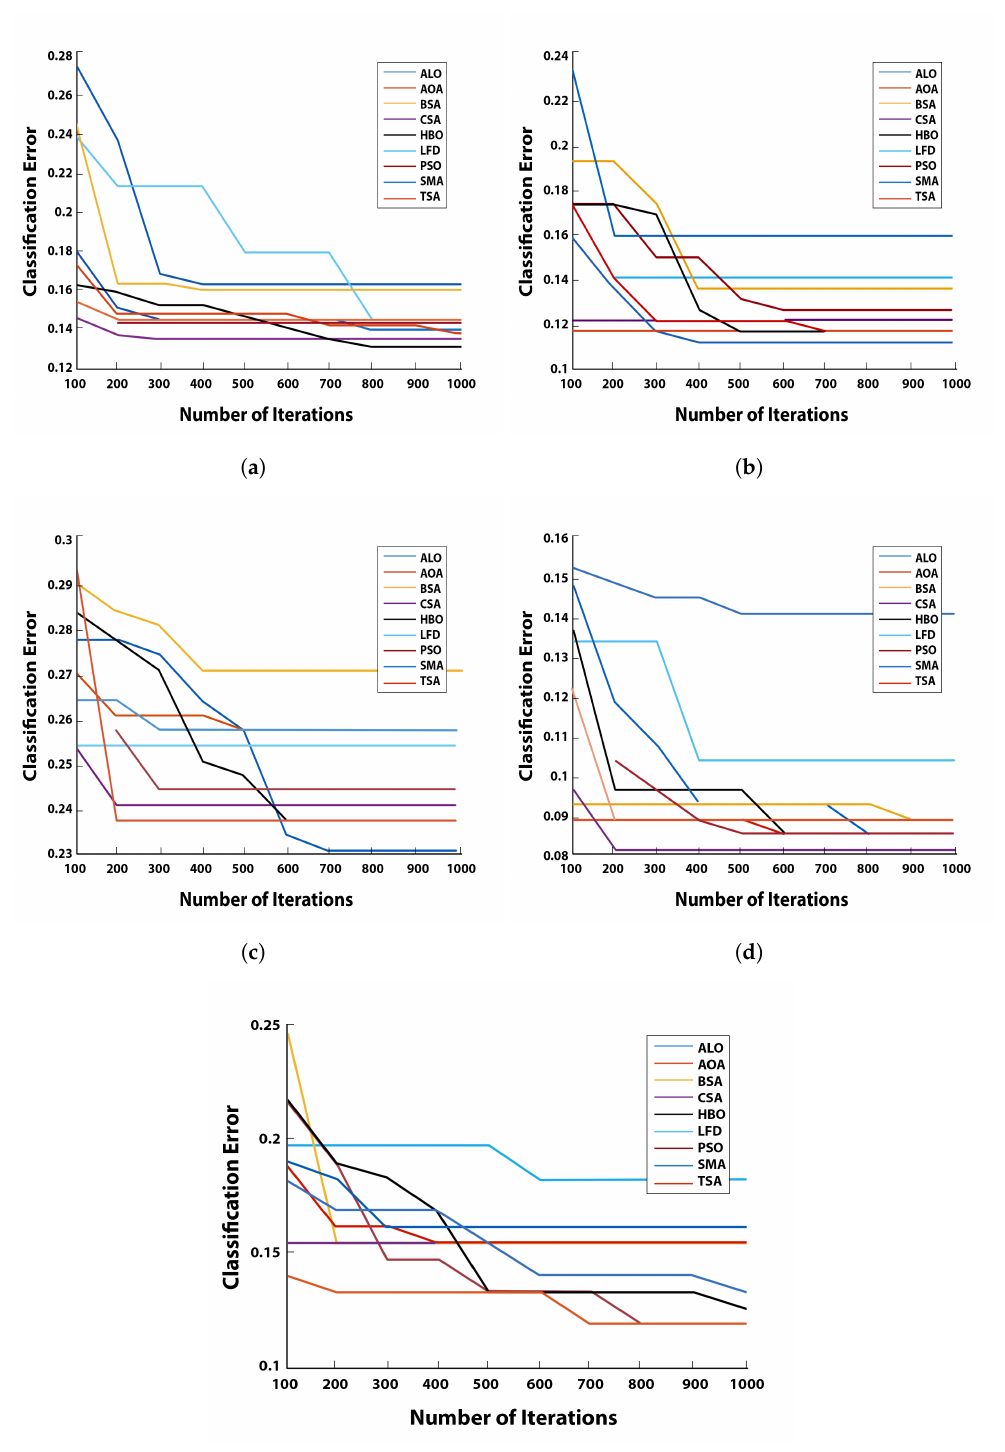
Figure 3. ( a ) Convergence Curve of the proposed approach for German dataset; ( b ) Convergence Curve of the proposed approach for Glass dataset; ( c ) Convergence Curve of the proposed approach for Heart-C dataset; ( d ) Convergence Curve of the proposed approach for Heart-StatLog dataset; ( e ) Convergence Curve of the proposed approach for Hepatitis